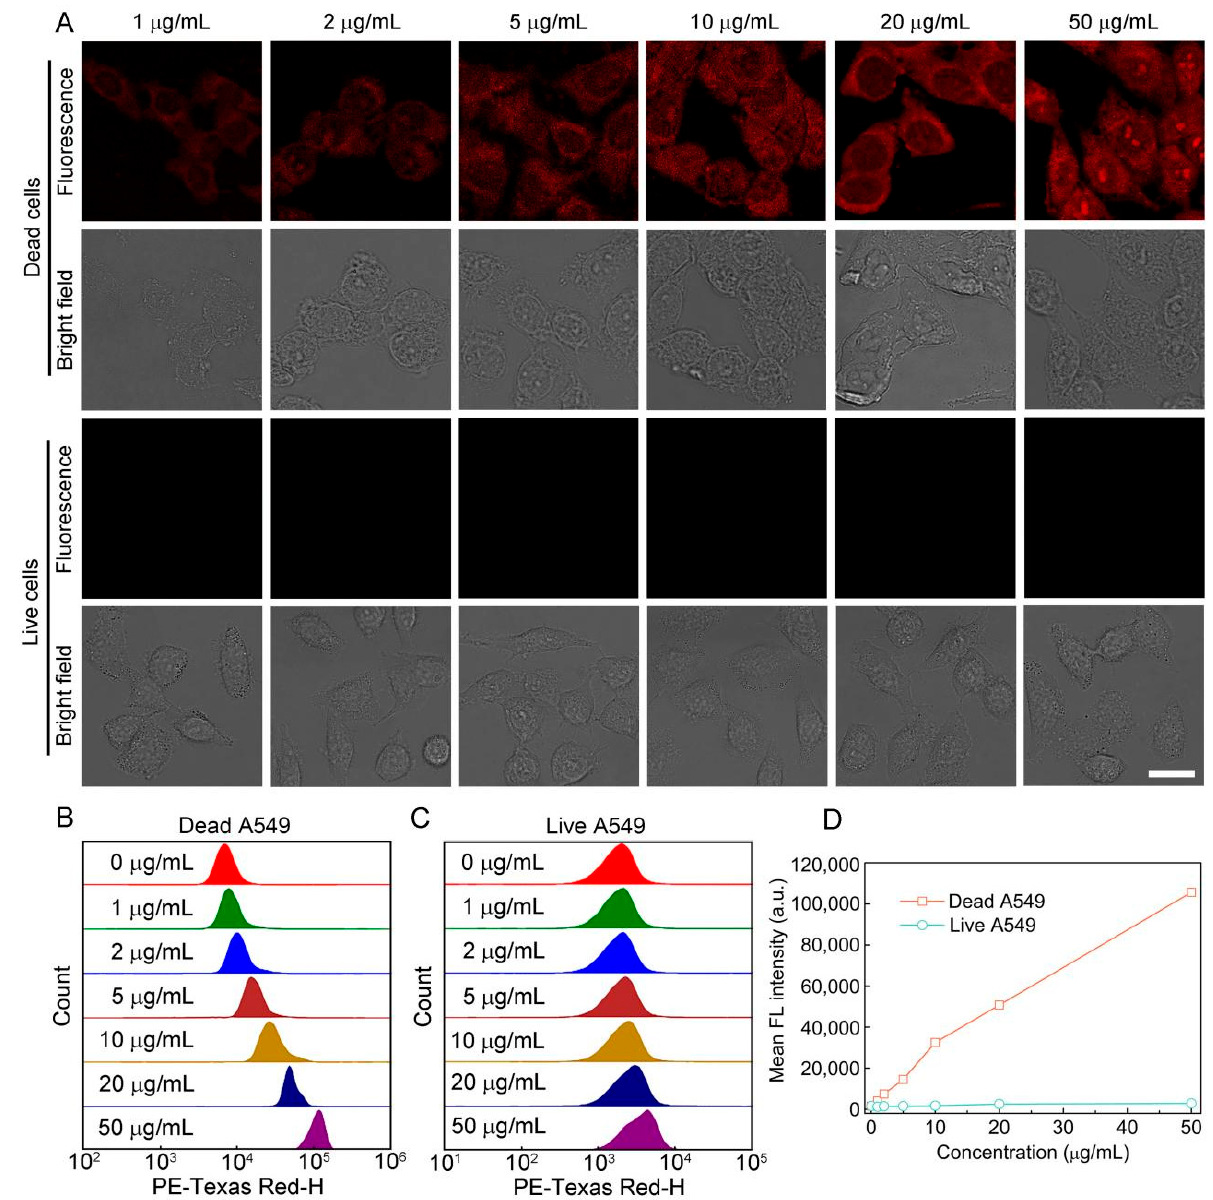
Figure 8. ( A ) Confocal images of dead and live A549 cells incubated with various concentrations of S ‐ OSiNDs for 30 s. Scale bar = 25 μ m. Flow cytometric results of dead ( B ) and live ( C ) A549 cells incubated with different concentrations of S ‐ OSiNDs for 30 s and ( D ) corresponding quantitative mean fluorescence intensities derived from the flow cytometric results.